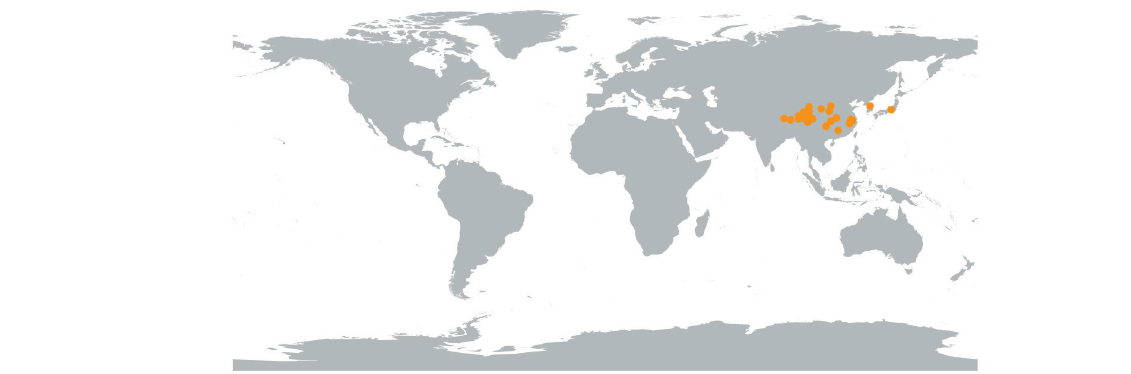
Fig. 23. Distribution of Malus toringo (Siebold) Siebold ex de